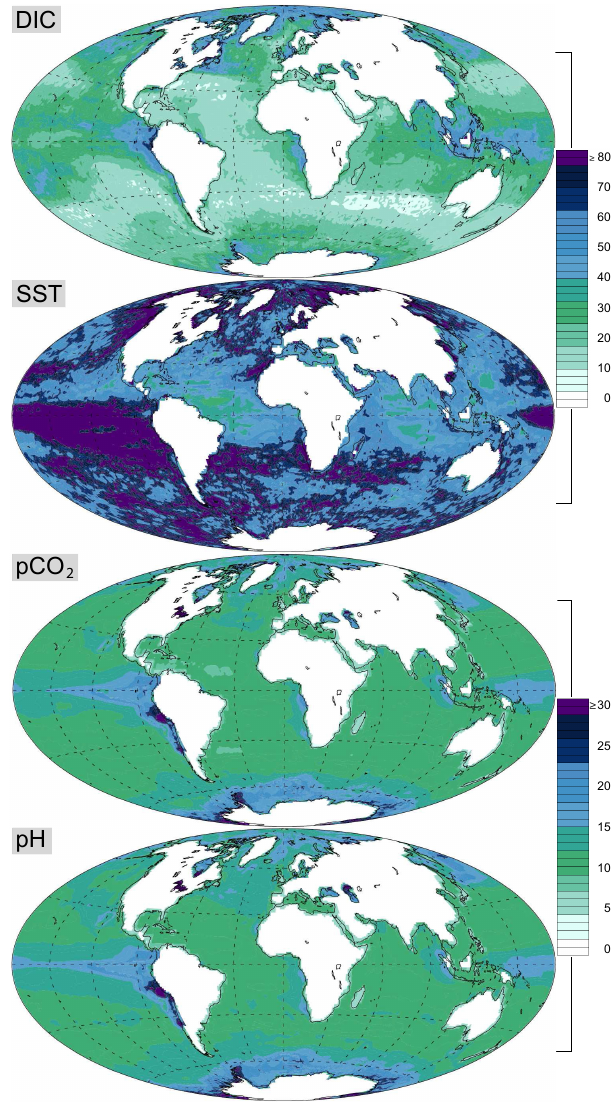
Figure 2. ToE (years) of dissolved inorganic carbon (DIC; mmolm − 3 ), sea-surface temperature (SST; ◦ C), p CO 2 (ppmv), and total pH. Ensemble mean, all variables on surface level. Note the different scales for DIC/SST and p CO 2